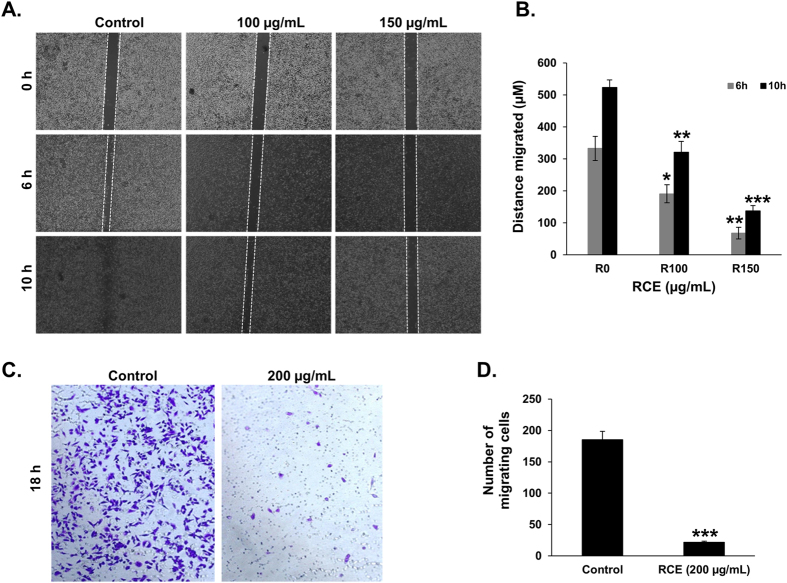
Rhus coriaria inhibits the migration of MDA-MB-231 human breast cancer cells.(A) Confluent culture of MDA-MB-231 cells were wounded by scratching with a pipette tip and the cells were incubated in DMEM supplemented with 10% fetal bovine serum without and with indicated concentrations of RCE. The wound was measured with an inverted microscope x 40 magnification and photographed. (B) Wound healing assay showing that RCE inhibited the migration of MDA-MB-231 breast cancer cells in concentration-dependent manner. Values represent the mean ± SEM (n = 3) distance (μm) that the cells have migrated in 6 and 10 h. Data are representative of three independent experiments. (C) Boyden chamber trans-well assay confirming that RCE inhibits the migration of MDA-MB-231 cells. Migrating MDA-MB-231 cells were stained with crystal violet and photographed with an inverted microscope at X100 magnification (Nikon Ti-U, Nikon). (D) Quantification of migrated MDA-MB-231 cells. The number of migrating MDA-MB-231 cells through Boyden chamber was quantified by counting at least 5 random fields at X200 magnification with an inverted microscope (Nikon Ti-U, Nikon). Data represent a mean ± SEM of cells counted per field and are representative of three independent experiments. Statistical analysis was performed using one-way ANOVA (*p < 0.05, **p < 0.005, ***p < 0.001).